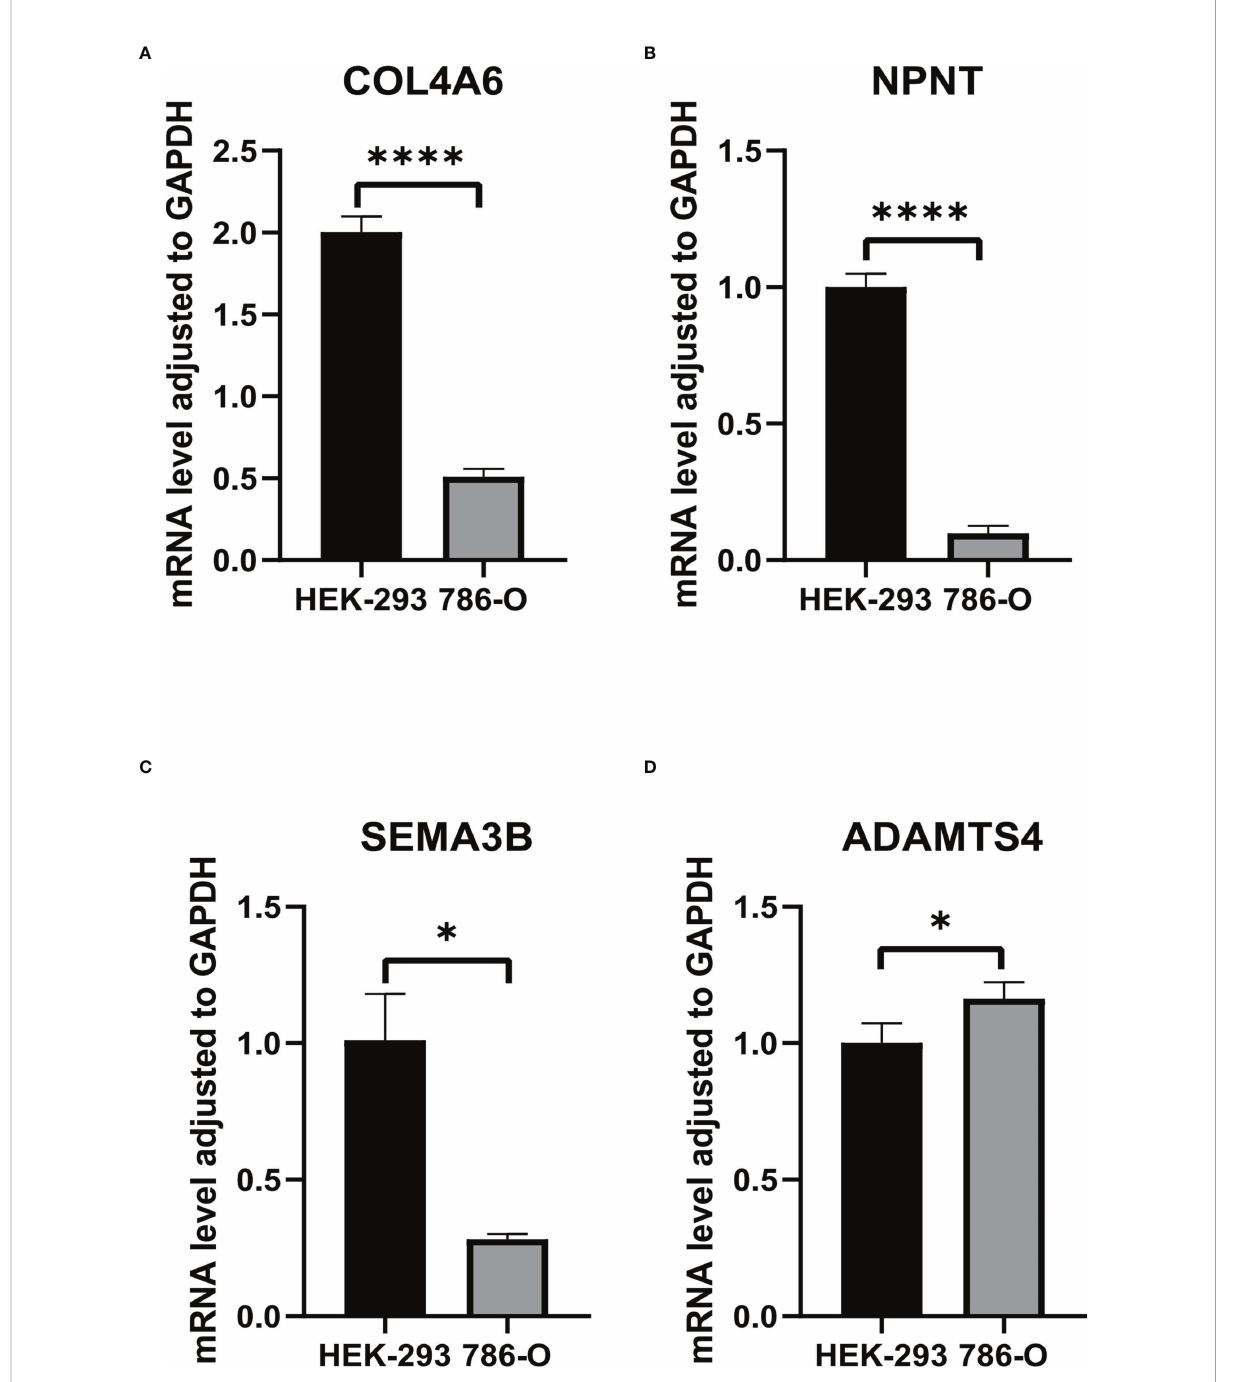
FIGURE 3 The RNA levels of (A) COL4A6, (B) NPNT, (C) SEMA3B, (D) ADAMTS4 in HEK-293 and 786-O cells. "*" represents P < 0.05, "****" represents P <